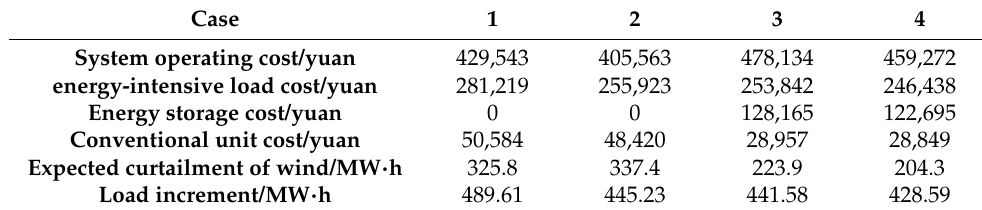
Table 7. Comparison of results in different